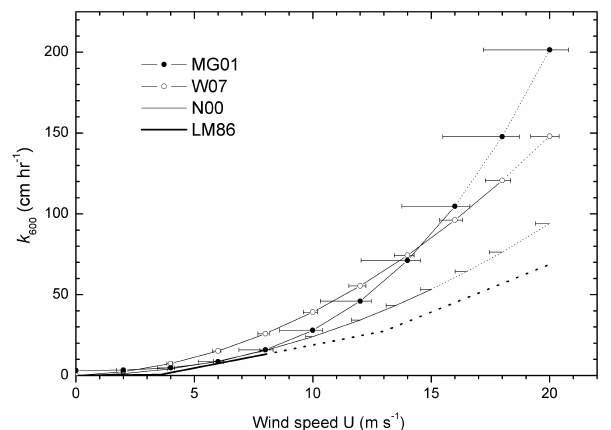
Fig. 5. Various transfer velocities ( k ) from selected gas transfer ve- locity formulations (see Table 1). Curves with circles indicate data from eddy covariance measurements: curves without circles show deliberate trace gas data. The error bars represent the change in wind speed based on best guess wind biases as given in Table 1. The solid lines indicate the range of wind speed measurements dur- ing the experiments, and the dotted lines indicate the extrapolated portions of the k-parameterisations. Note that the covariance rela- tionships given in Table 1 have been modified here to allow for the difference in Schmidt number (resulting in a reduction in k of about